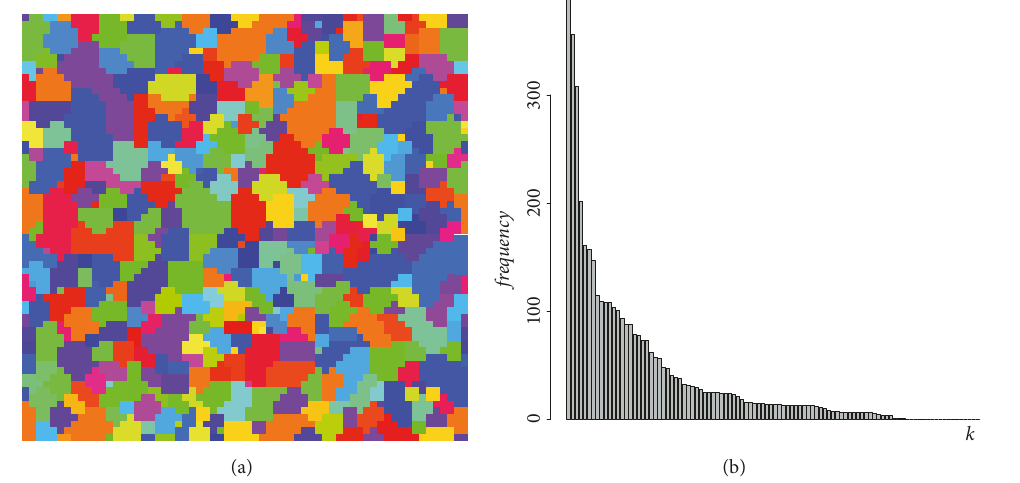
Figure 9: Example of a fixed point solution for 𝑠 = 10 , 𝑝 𝑎 = 0.25 , and 𝑝 𝑏 = 0.75 . (a) The spatial patterns of selected schools (the colormap labels the states {1,2,. .. 100} ). (b) The distribution of the number of students per school.